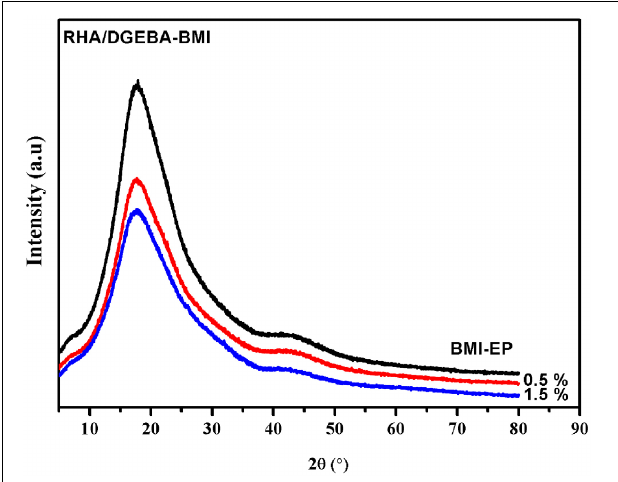
FIGURE 11 | XRD of BMI-EP, 0.5 and 1.5 wt.% RHA/DGEBA-BMI nanocomposites.